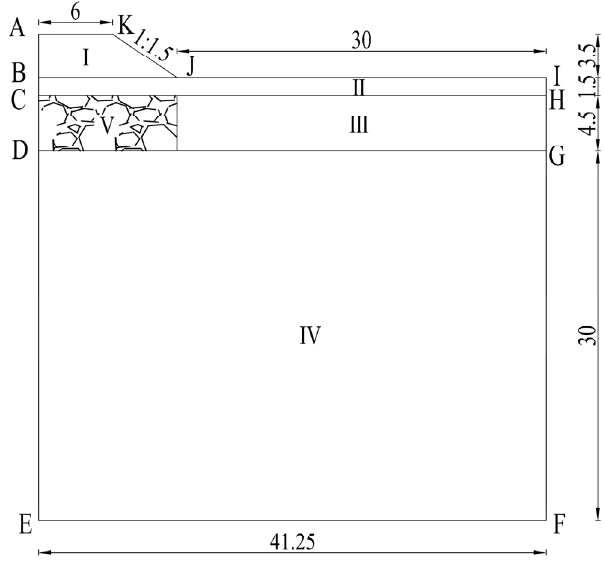
Figure 3. Geometric model and calculation unit division of the subgrade structure. A, B, C, and D are node numbers of the geometric model (Unit: m).